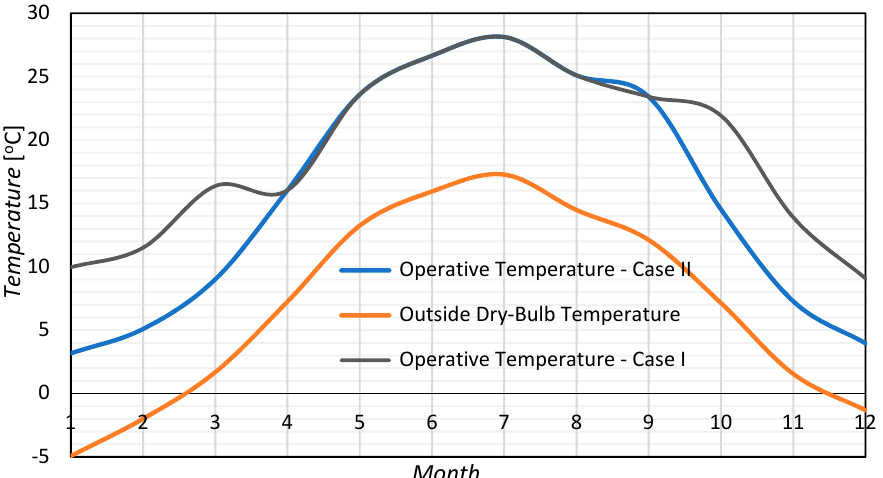
Figure 10. Changes in indoor and outdoor temperature in the absence of heating in the analyzed modular house.